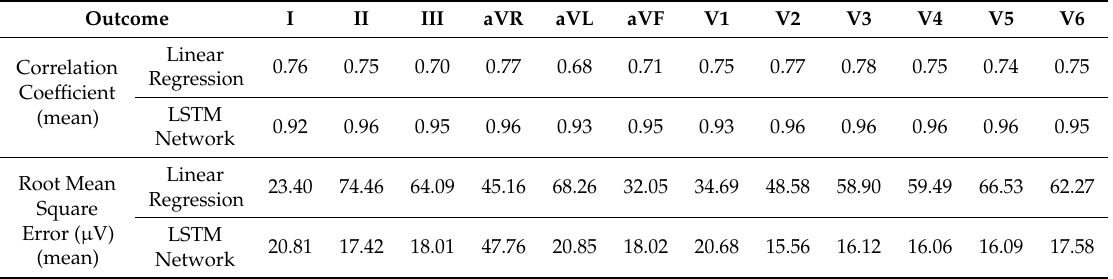
RMSE: root mean square error, ECG: electrocardiogram.